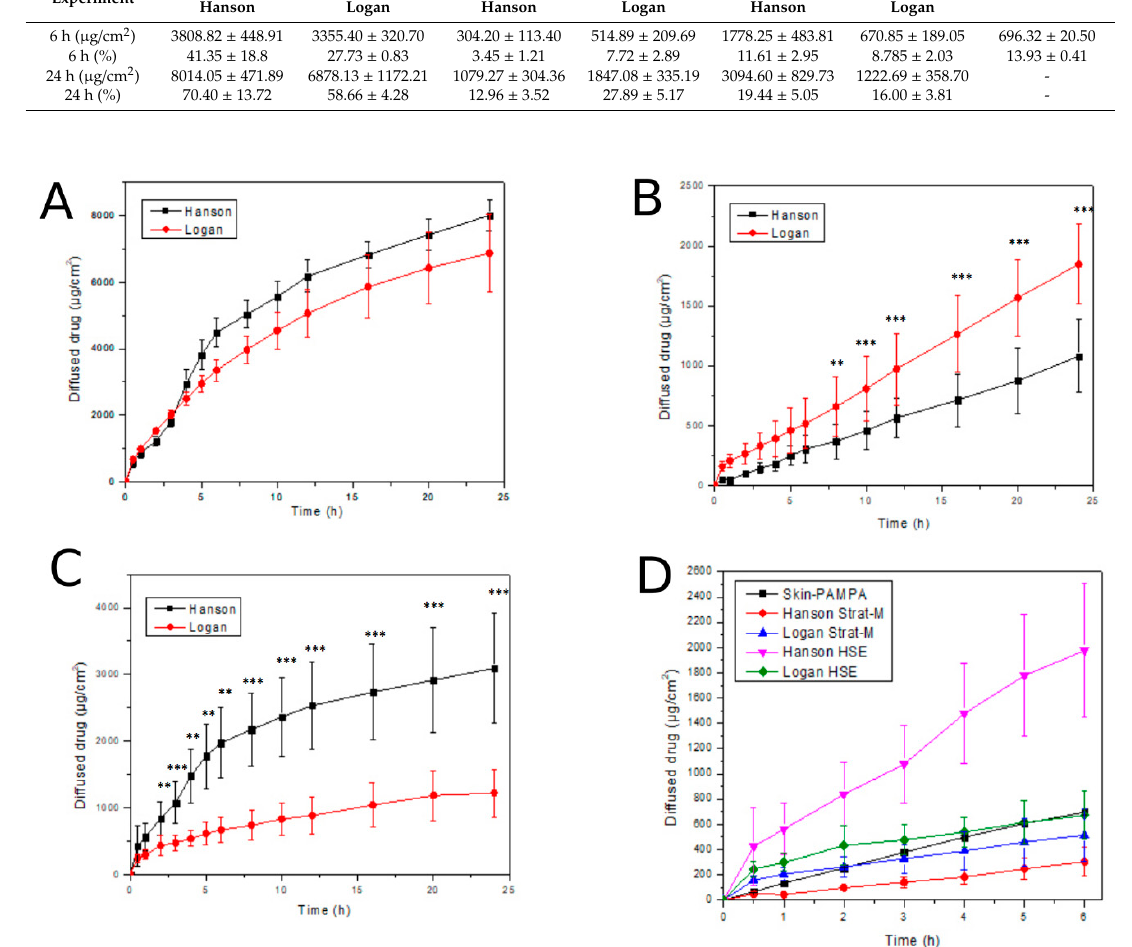
Figure 4. In vitro drug diffusion and ex vivo skin penetration studies. ( A ): In vitro release of lidocaine through cellulose acetate membrane (24 h); ( B ): In vitro penetration of lidocaine through Strat-M ® membrane (24 h); ( C ): Ex vivo penetration of lidocaine through HSE (24 h); ( D ): Comparison of various penetration methods with various membranes (6 h). p < 0.05 *, p < 0.01 ** and p < 0.001 *** compared to each other within each one figure.